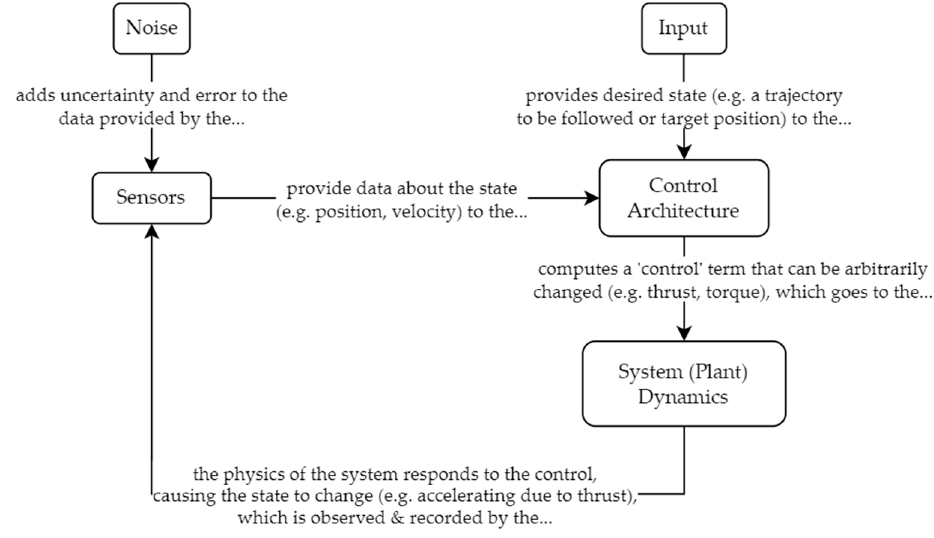
Figure 3. Flowchart showing the topology of a generic system, explaining the connection between the sensors, the control architecture, and the system dynamics.